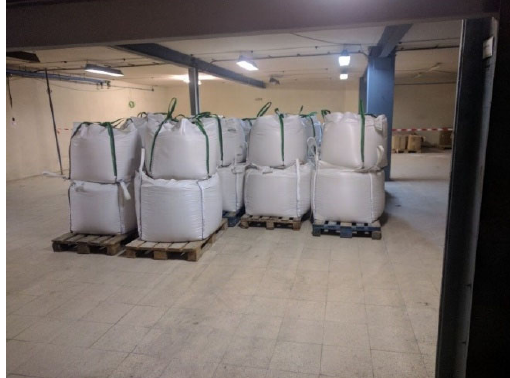
Figure 7. General view of the loading test with sand